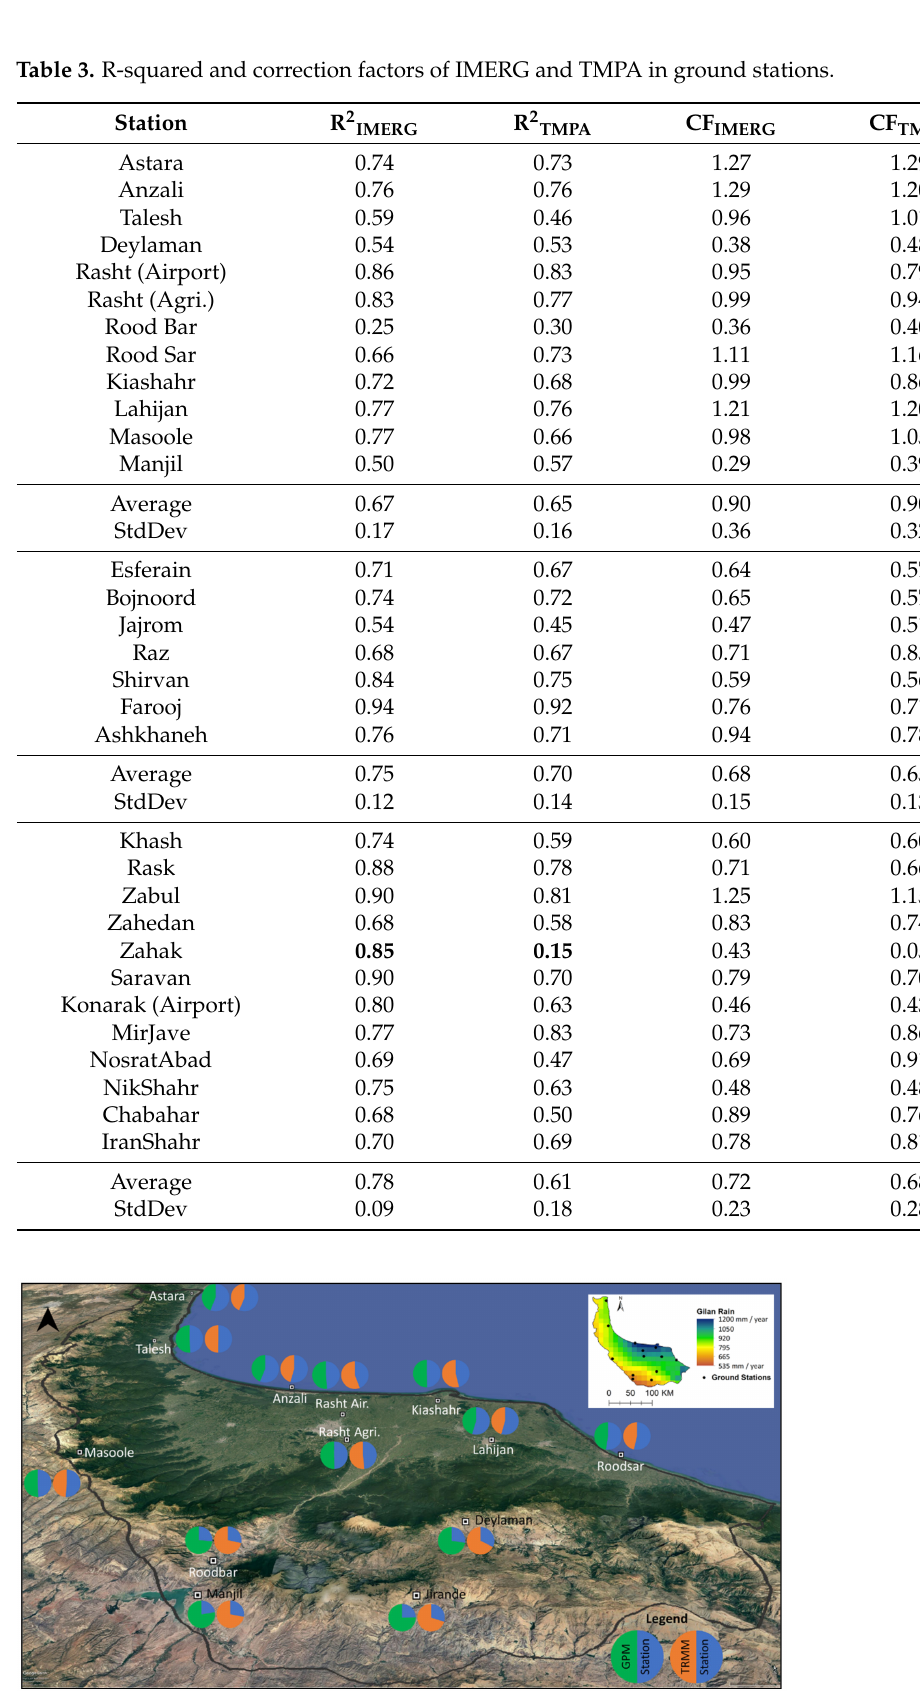
Figure 6. Precipitation correction coefficient for Gilan. The legend is shown when satellite and station have an equal amount. The image is tilted to create a 3D